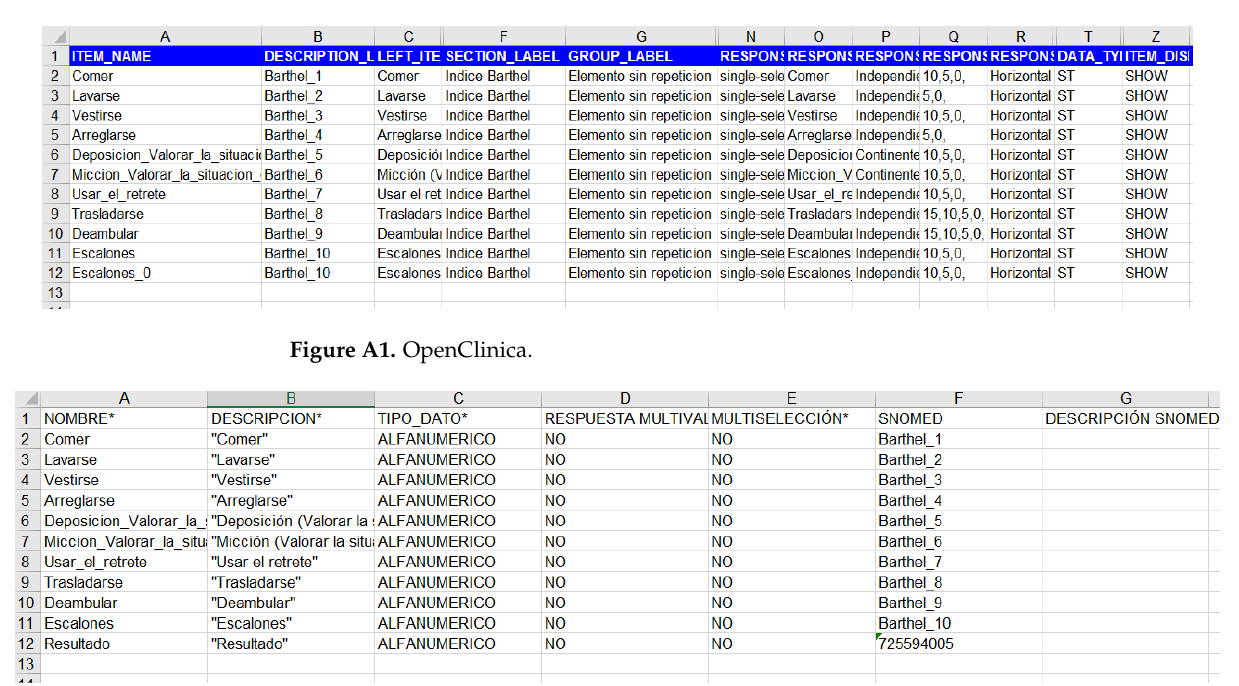
Figure A2. Diraya—Andalusian Health Service Electronic Health Record system.